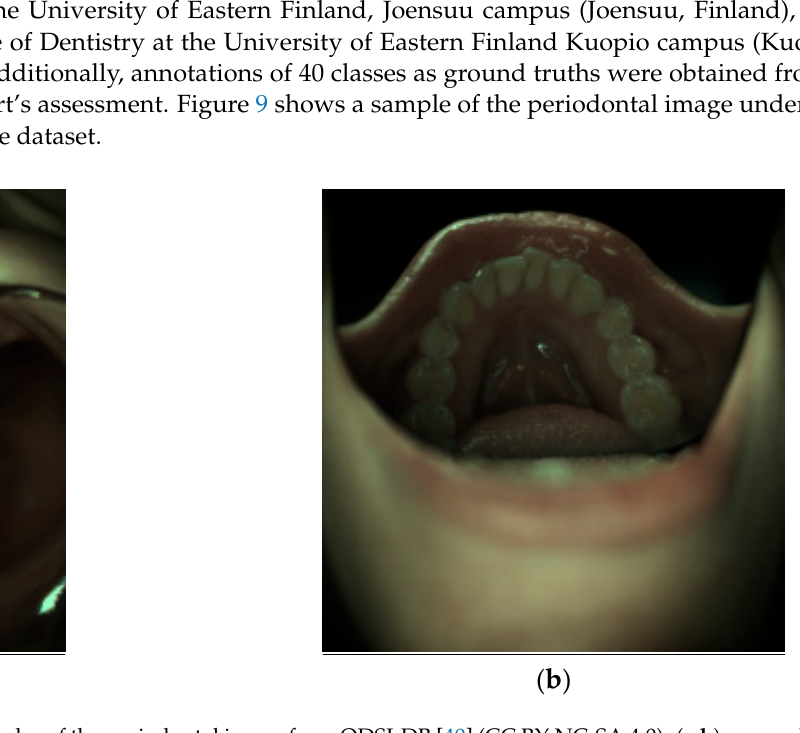
Figure 9. Samples of the periodontal image from ODSI-DB [40] (CC BY-NC-SA 4.0). ( a , b ) are rendered from reflectance spectral image computationally with camera sensitivity in Figure 8 and spectral power distribution of D65 in Figure 5. Table 4. Samples chosen for the one-vs-rest classification.